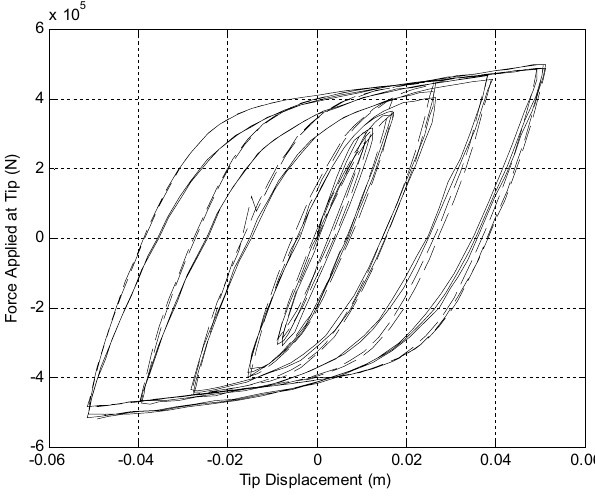
Fig. 4. Comparison between simulated (--) and experimental (–) data, Specimen 2. (Bolted Fixed